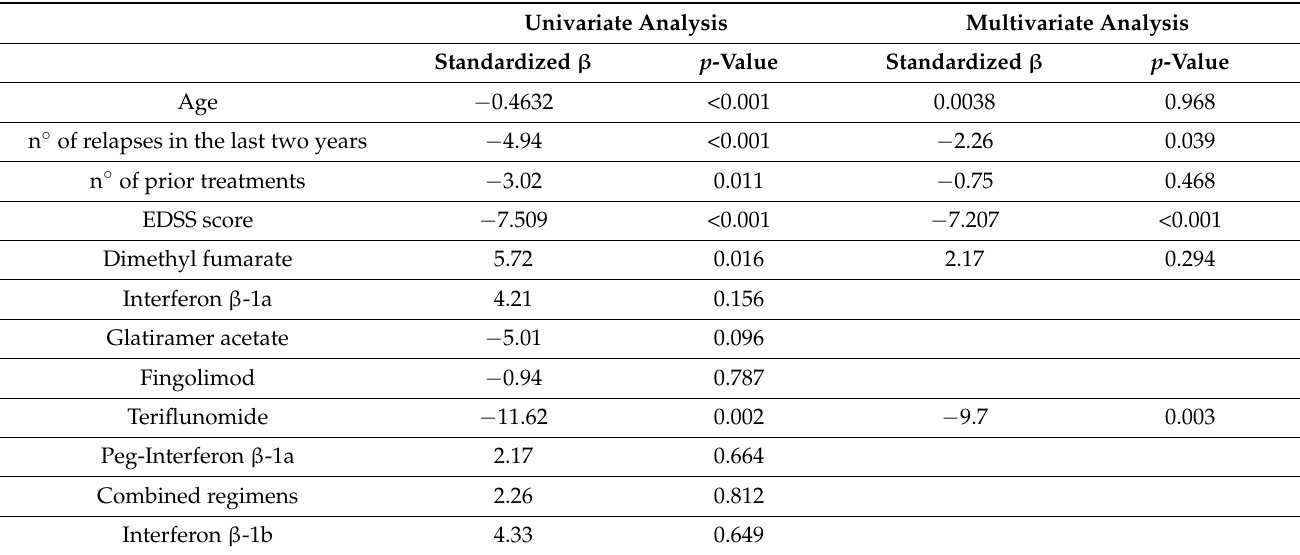
Table 3. Univariate and multivariate linear regression analysis: standardized Beta coefficients of independent variables and p -values assessed for Physical Health Composite Score.